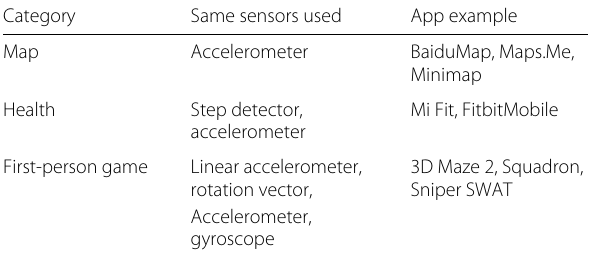
Table 7 Some apps in the same category use the same sensors